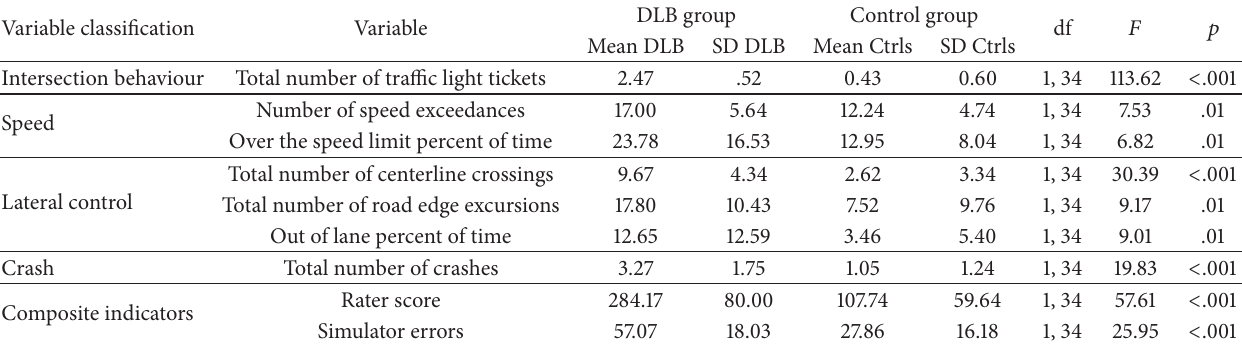
Table 1: Differences in simulated driving performance between participants with Dementia with Lewy Bodies (DLB) and controls. Variable